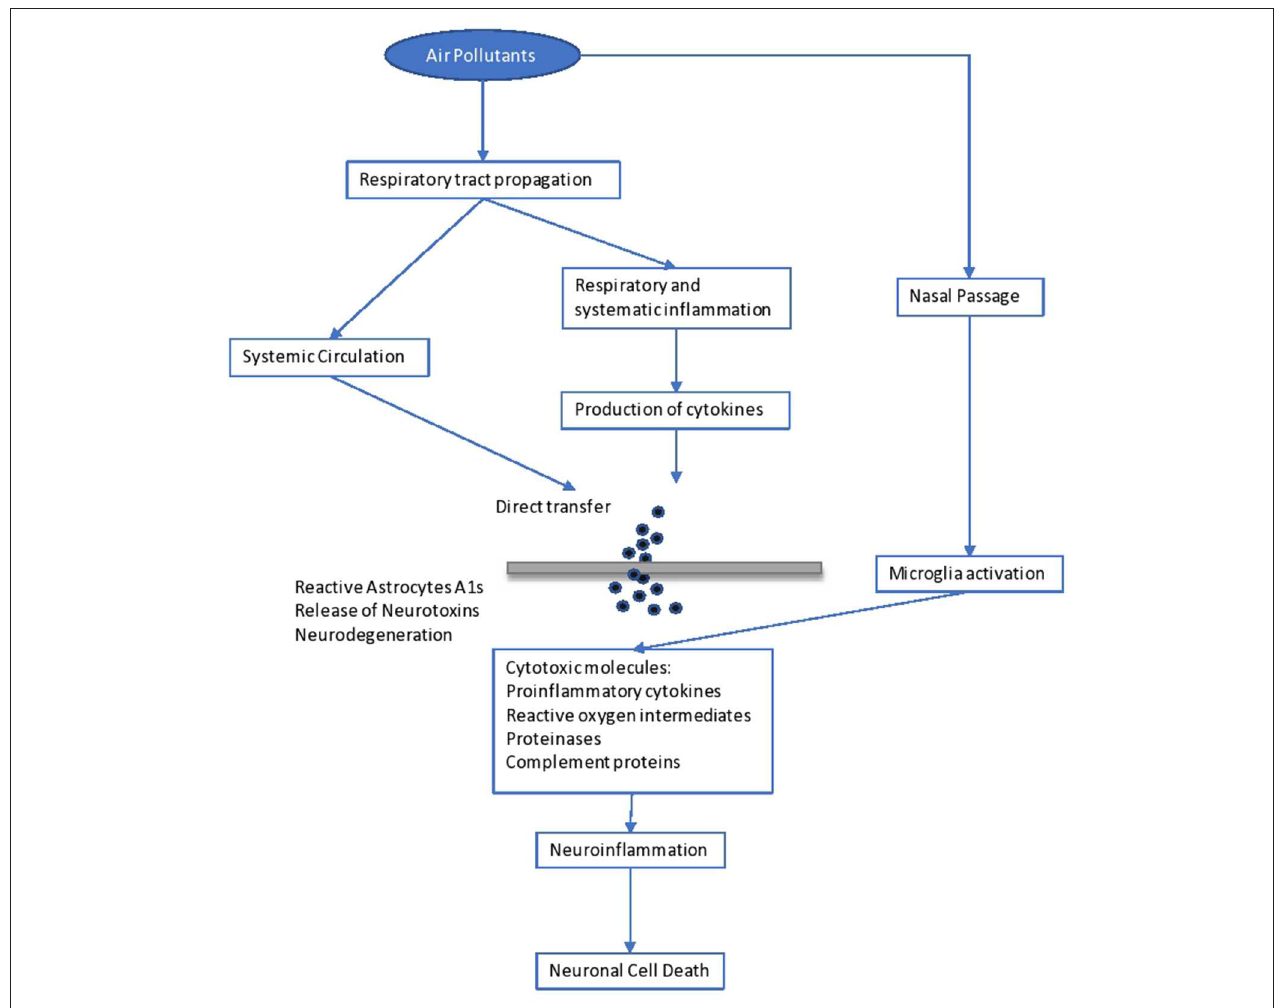
FIGURE 1 | Impact of air pollutants on the